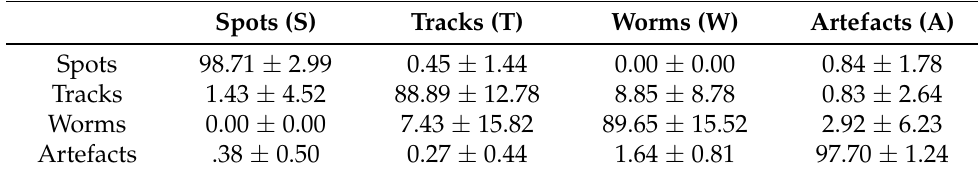
Table 10. Confusion matrix of the network with input VGG16 and threshold schema (8) t = 0.90. Data remaining = 62.60 ± 2.88 (S 42.03 ± 5.65; T 29.91 ± 6.55; W 18.445 ± 7.22; A 94.97 ± 2.17), recognition rate = 96.95 ±